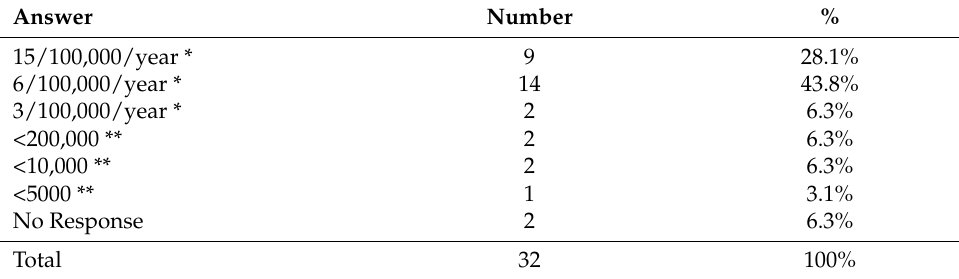
Table 5. Definition of rare disease by annual incidence rate * or annual incidence